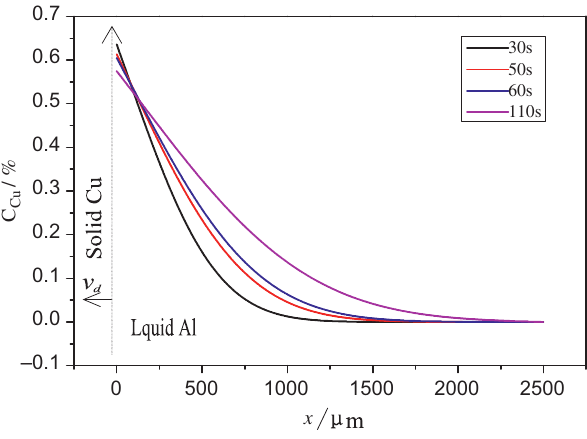
Figure 8: Calculation results of Cu concentration distribution in the transition